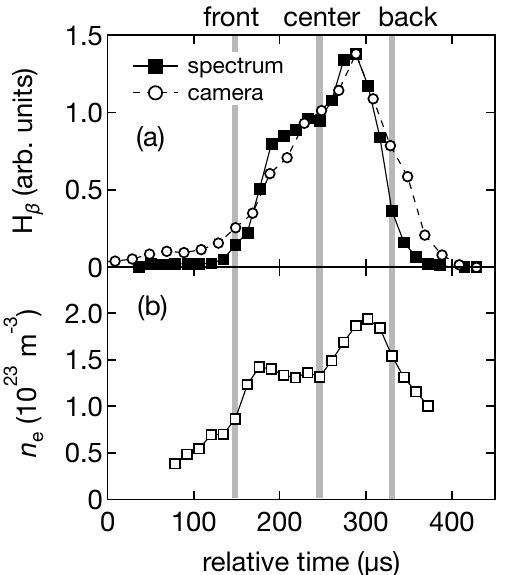
Figure 4. Spatial profile of the ablation cloud: ( a ) integrated intensities of H β with the spectral measurement (solid squares) and of the camera image with a virtual band-shaped line-of-sight images (open circles) ( b ) n e derived from the analysis of the H β profile in the spectral